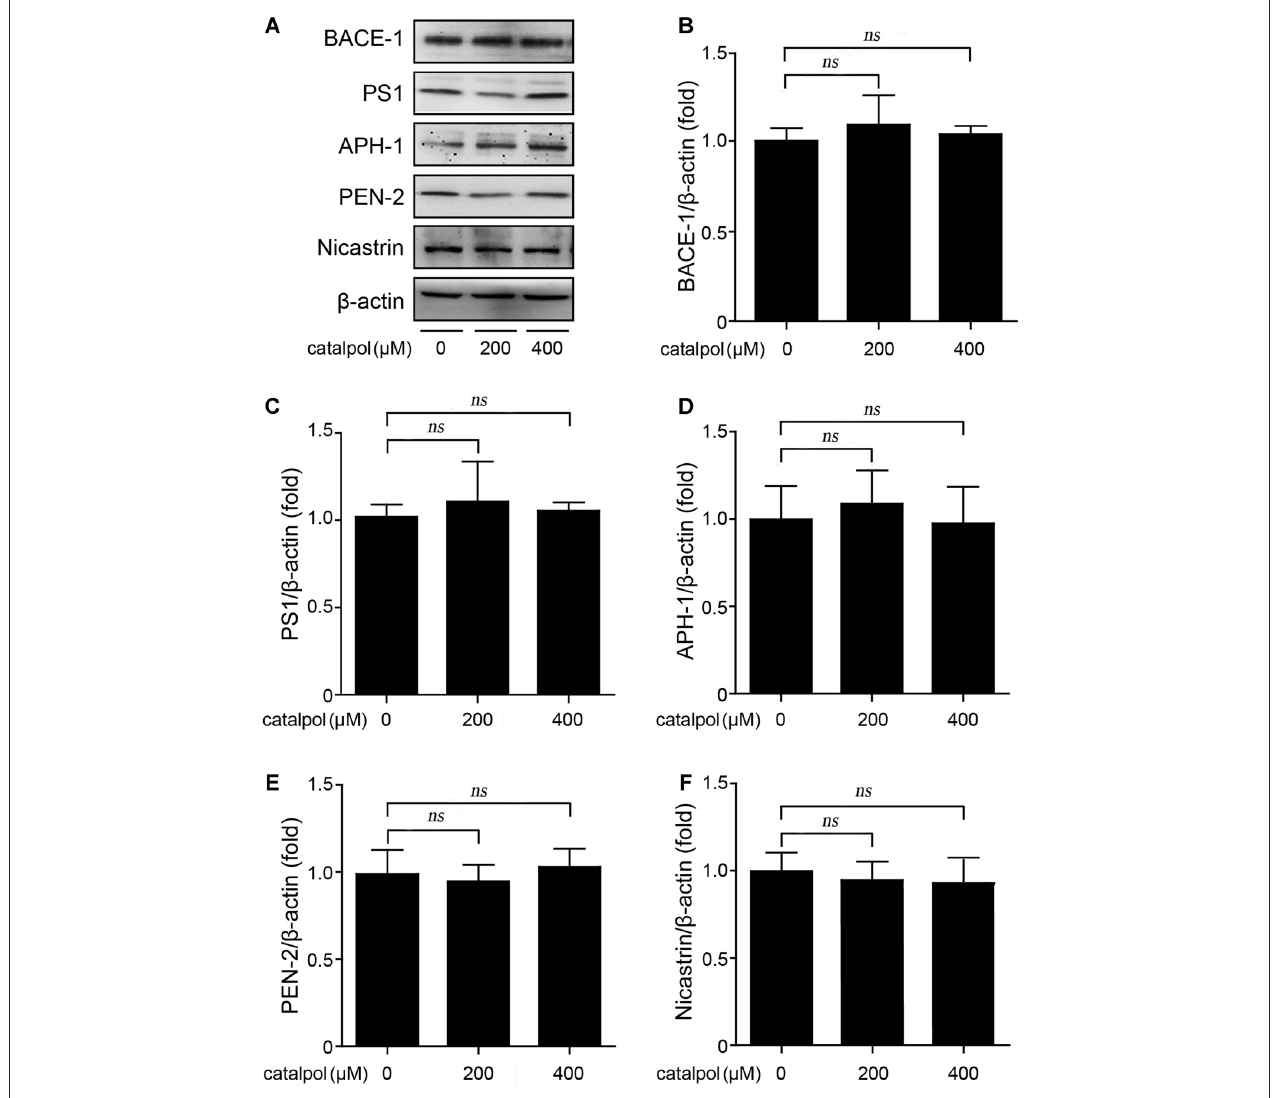
FIGURE 2 | Catalpol did not affect the protein levels of β - and γ -secretase in SweAPP N2a cells. (A–F) SweAPP N2a cells were treated with catalpol (200 and 400 µ M) for 18 h. Western blot was carried out to detect the expression levels of β -secretase (BACE-1) and the subunits of γ -Secretase (PS1, APH-1, PEN-2 and Nicastrin). (A) Immunoblot analysis and (B–F) quantifications showed catalpol did not show significant effect on the expression of the detected proteins related to amyloidogenic amyloid precursor protein (APP) proteolytic processing. The data are expressed as the mean ± SEM. n = 3. The p values were calculated